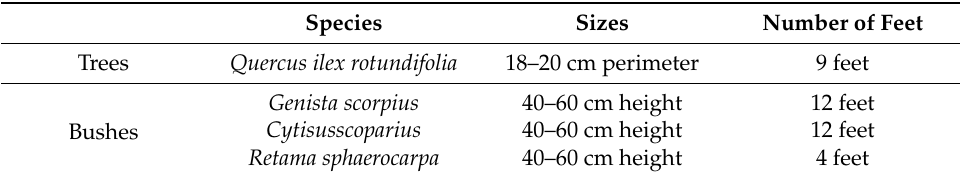
Table 4. Selected